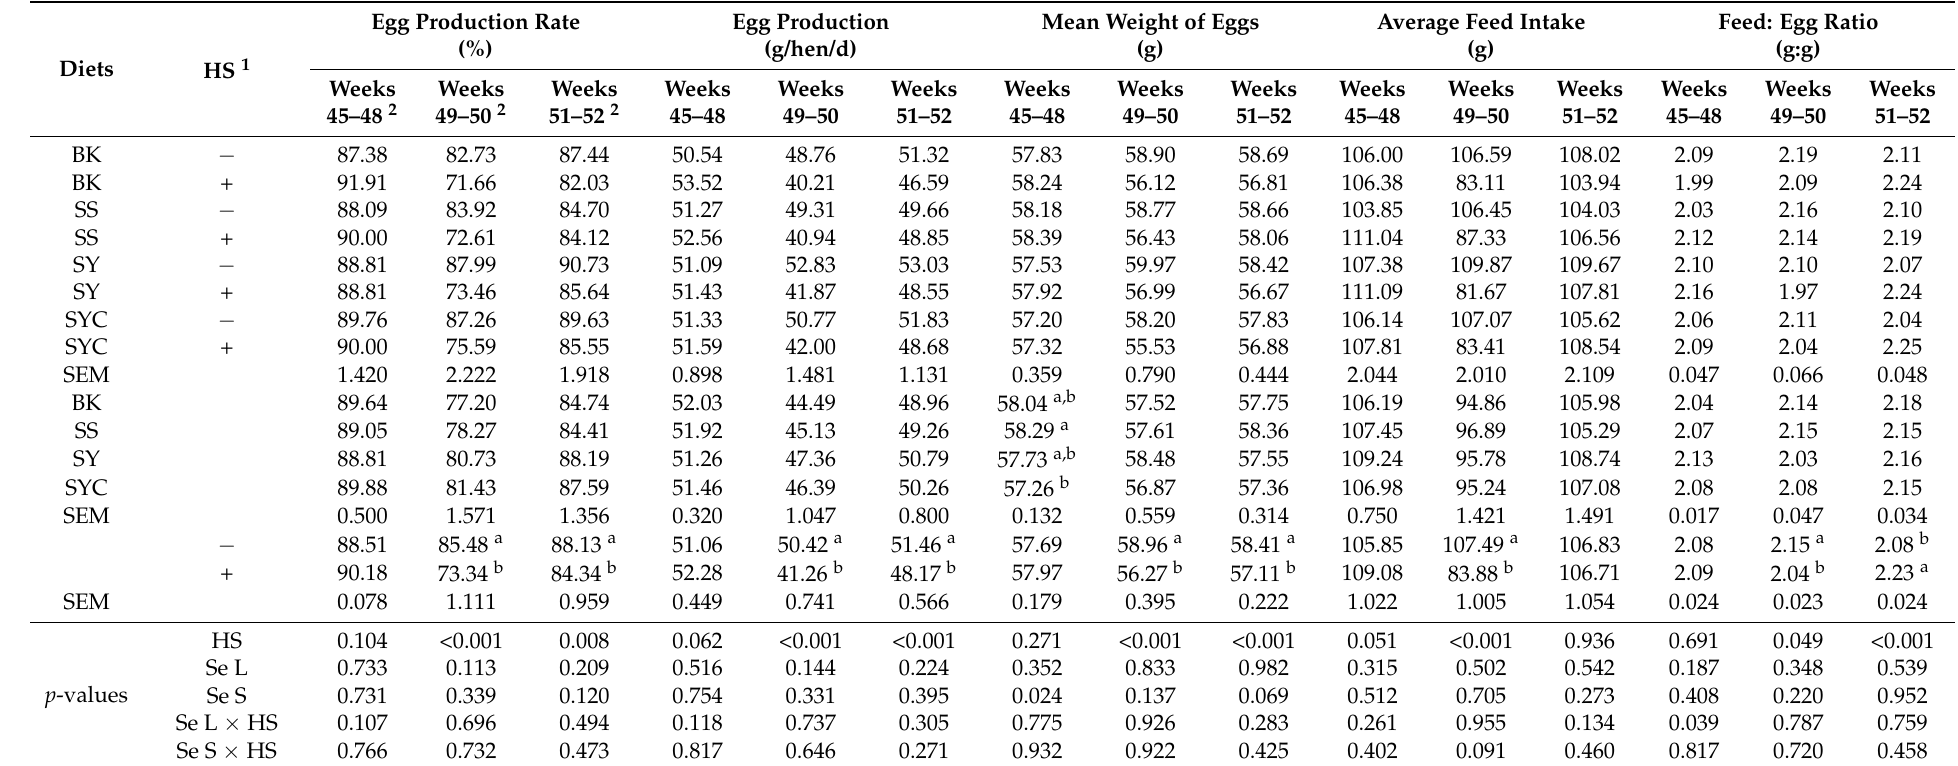
Different letters indicate statistically significant differences ( p < 0.05). BK: basal diet, SS: sodium selenite, SY: selenium yeast, SYC: selenium-enriched yeast culture, Se L: selenium levels, and Se S: selenium sources. 1 HS − = Normal temperature (26 ± 2 ◦ C), HS+ = Circulating high temperature (26 ± 2 ◦ C~33 ± 2 ◦ C). 2 Weeks 45–48, 49–50, and 51–52: each group has six replicates ( n =